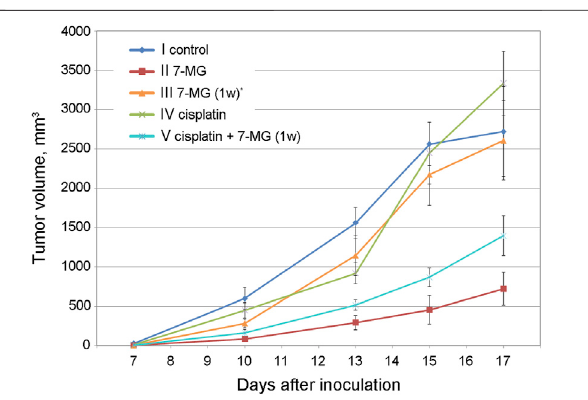
FIGURE 3 | Dynamics of US-322 tumor growth in female CBA mice at different treatment regimens.